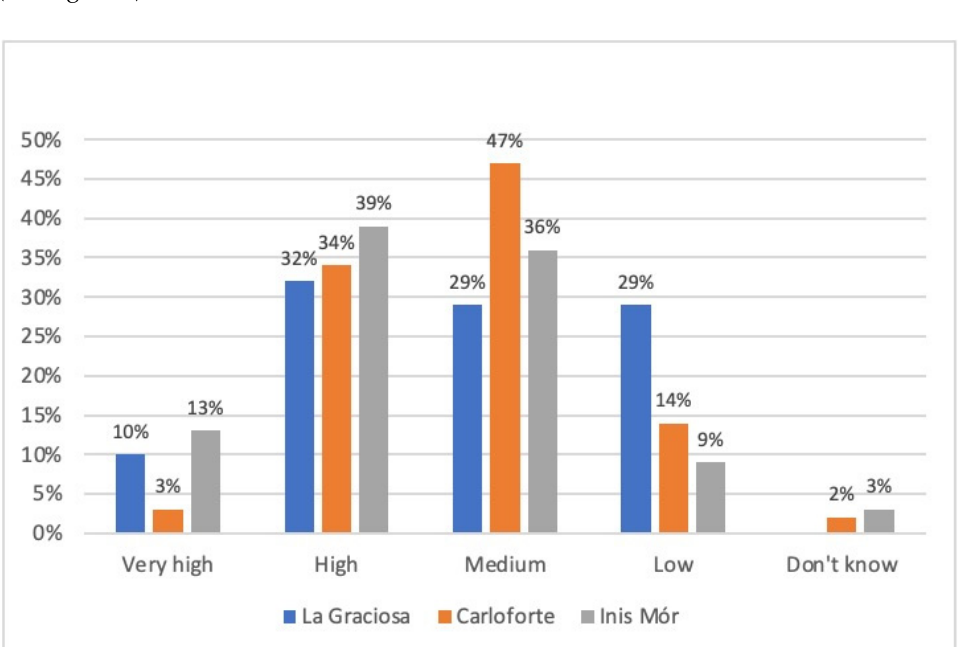
Figure 2. Importance of energy saving and RET use for households in the three islands. In our survey, we asked respondents if the factors listed in Figure 3 would motivate them to accept SGs and use smart appliances. The answer categories provided were “Strongly motivating”, “Motivating”, “Slightly motivating”, “Not motivating” and “I don’t care.” In terms of respondents’ motivations to take part in the SG and DR pro- grammes, our findings echo those of the earlier studies discussed in Section 2, which have found that people are motivated by economic and environmental concerns. By far, the majority of respondents from all three islands (88% in La Graciosa, 78% in Carloforte and 83% in Inis Mór) would be strongly motivated or motivated by a reduction in their energy bills to accept SGs and the use of smart appliances (see Figure 3). In relation to environ- mental and altruistic motivations, the results show that the majority of respondents (75%